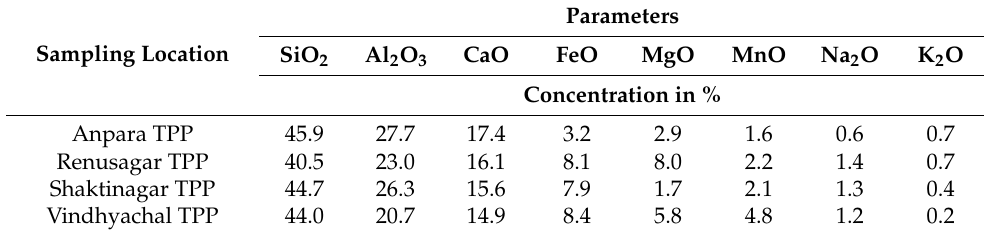
Table 2. Characteristics of the fly ash samples.